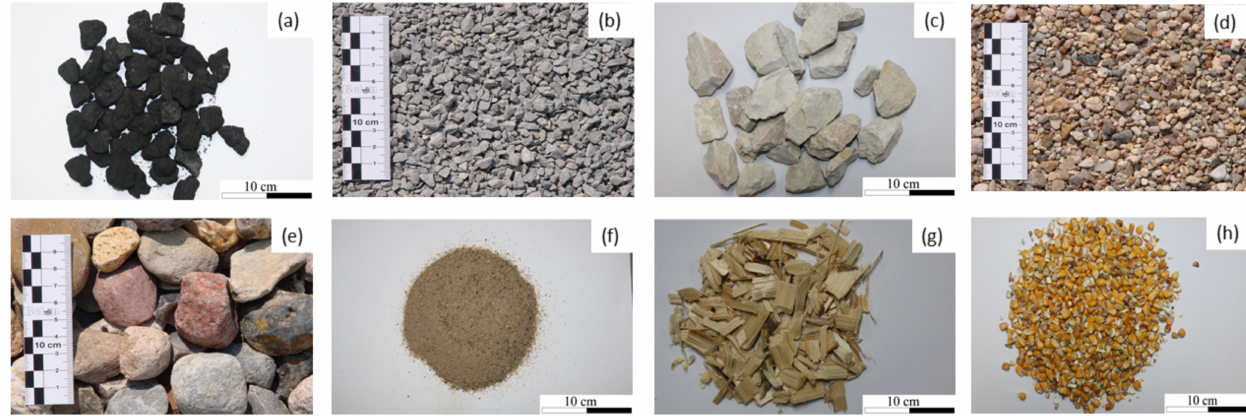
Figure 3. Granular materials considered to quantify the boundaries of the investigated material domain: ( a ) coke; ( b ) stone chippings 2-5 mm; ( c ) limestone; ( d ) gravel 2/8 mm; ( e ) gravel 16/32 mm; ( f ) dry sand; ( g ) woodchips; ( h ) dry